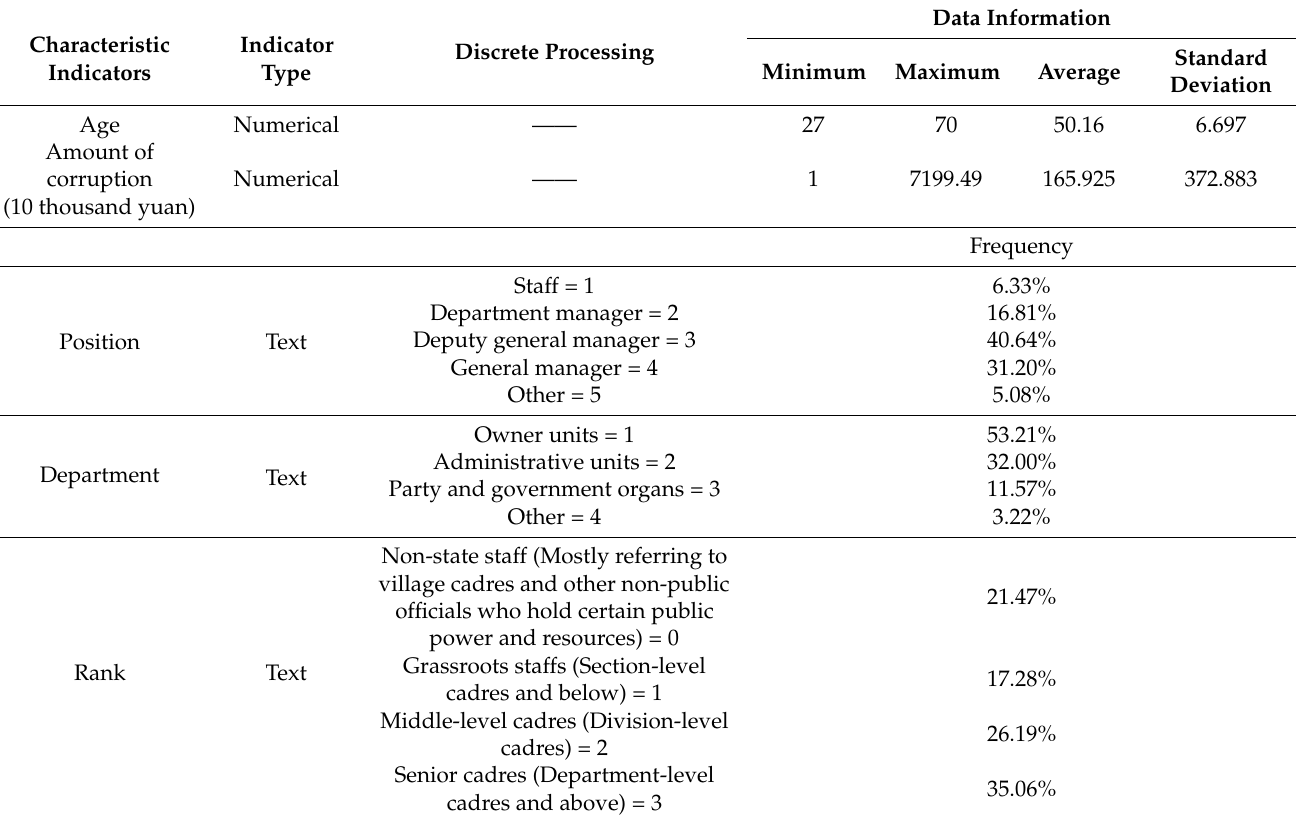
Table 2. Discretization of indicators of bidding corruption perpetrator characteristics and overall situ-